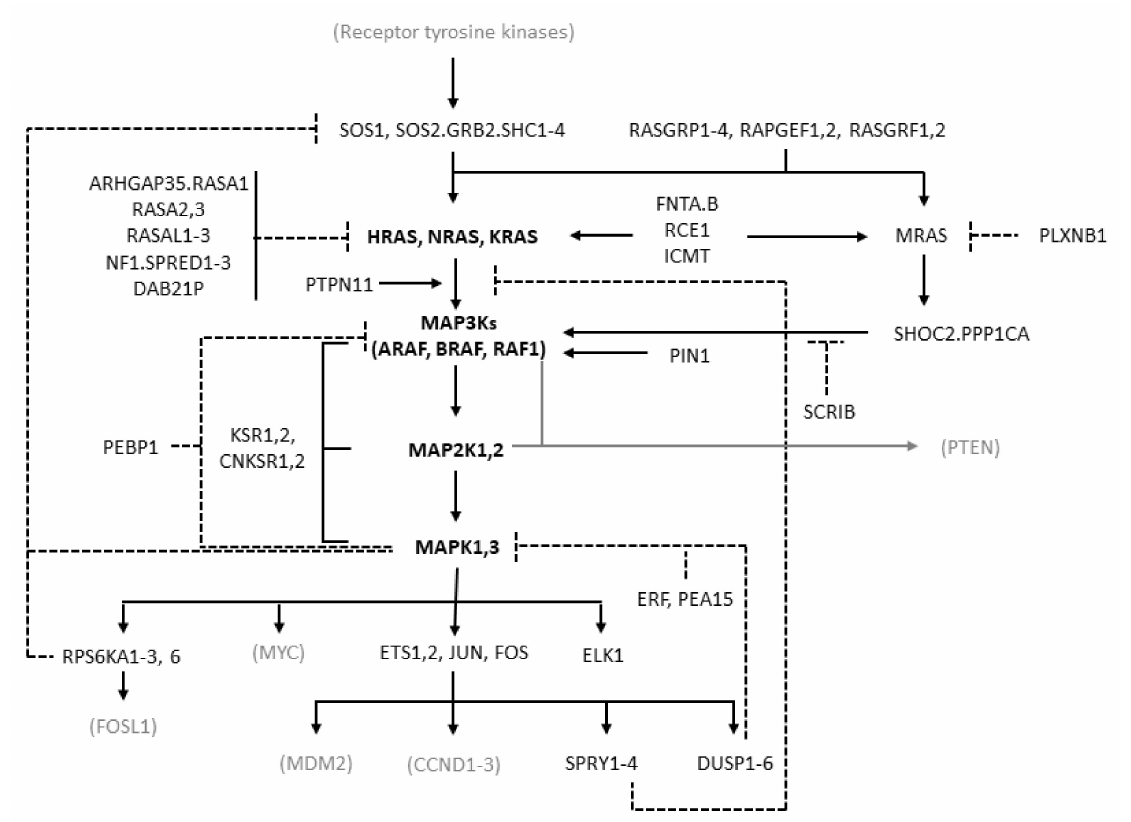
Figure 1. Diagram of the RAS/RAF/MEK/ERK pathway showing the molecules considered in this study. The diagram is derived from the “RAS pathway v2.0” diagram curated by the RAS Initiative of the US National Cancer Institute, originally published by the National Cancer Insti- tute (https://www.cancer.gov/sites/g/files/xnrzdm211/files/styles/cgov_enlarged/public/cgov_ image/media_image/800/100/files/ras-pathway-enlarge.jpeg?h=4233ef75&itok=aJpyY4D- (ac- cessed on 20 September 2022)). Solid lines with arrows represent activating signals. Dashed lines represent inhibitory signals. In bold are the pivotal molecules of the pathway: the RAS isoforms and the molecules of the ERK cascade. Shown in black but not bold are the other molecules of the extended pathway that are considered in the present study (direct activators or inhibitors of RAS and molecules involved in the feedback mechanisms of the pathway). In gray and in parentheses are some other important molecules not considered in the present study. Names separated by periods represent proteins that are believed to form physical complexes. The bracket connecting KSR1/2 to the RAF, MAP2K, and MAPK genes indicates a scaffolding